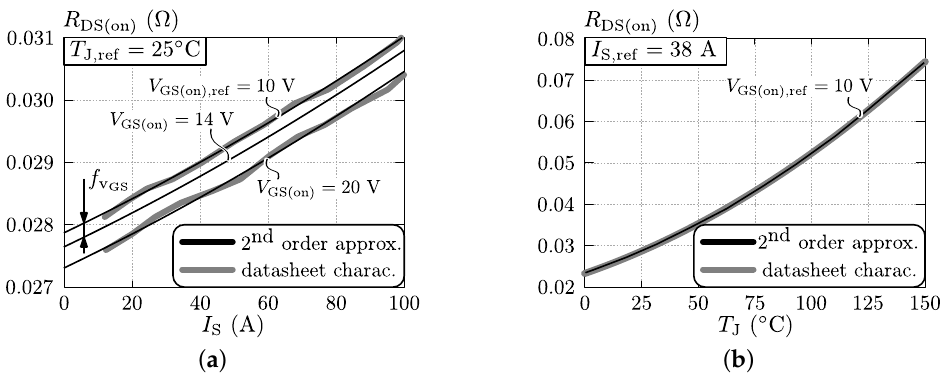
Figure 7. Dependency of the on-resistance R DS ( on ) on ( a ) the switch current I S and ( b ) the junction temperature T J , regarding the FAIRCHILD FCH76N60NF